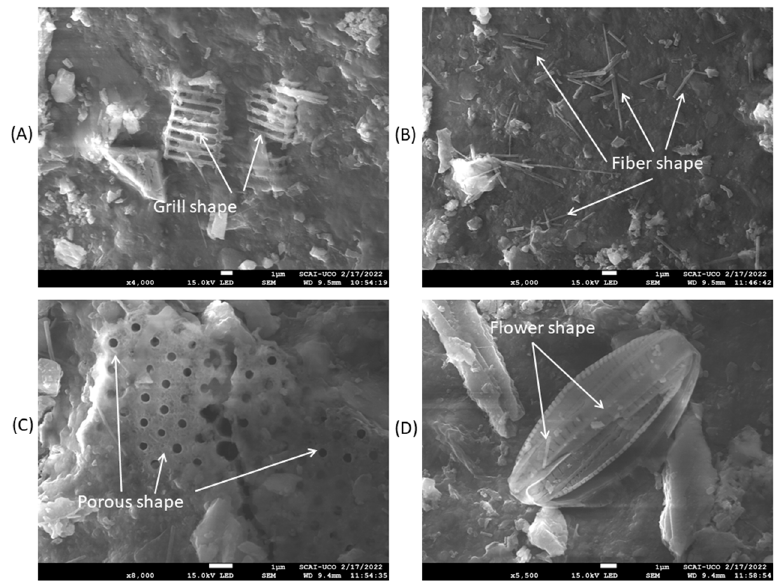
Figure 3. Different “sophisticated shapes” resulting from the biomineralisation of the shells on the outside before heating: ( A ), ( B ), ( C ) and ( D ).